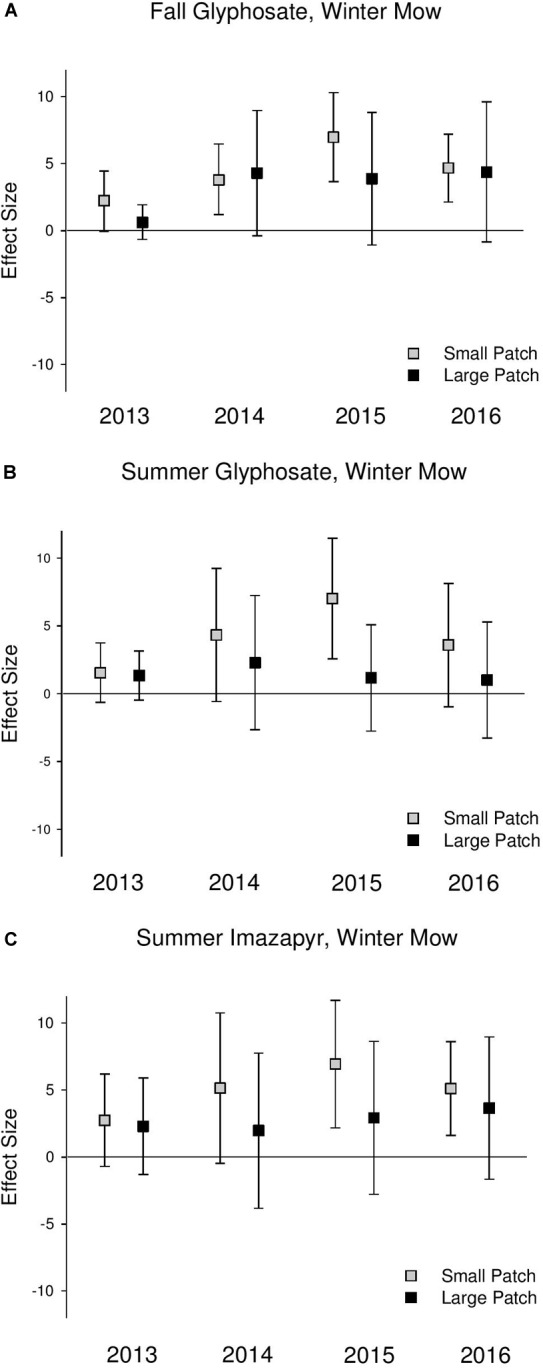
Effect size graphs for native emergent perennial cover for three herbicide treatments [(A) fall glyphosate, winter mow, (B) summer glyphosate, winter mow, and (C) summer imazapyr, winter mow]. Points are effect sizes at each scale, in each year, bounded by the upper and lower limits of the 95% confidence interval.